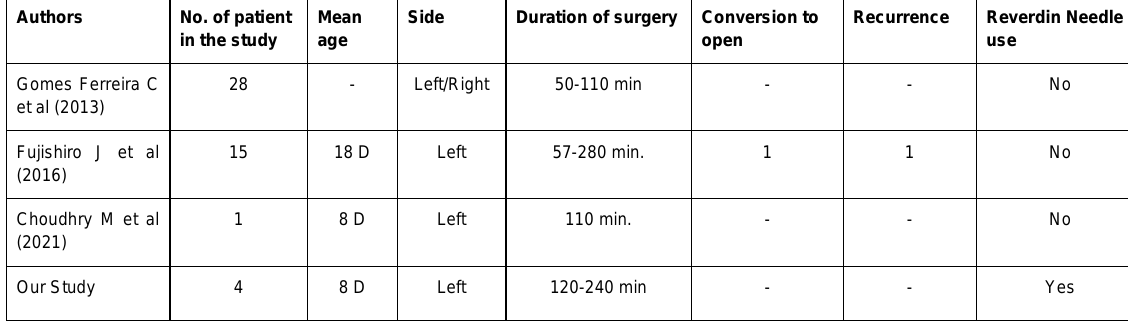
Table 2: Comparative table for literature